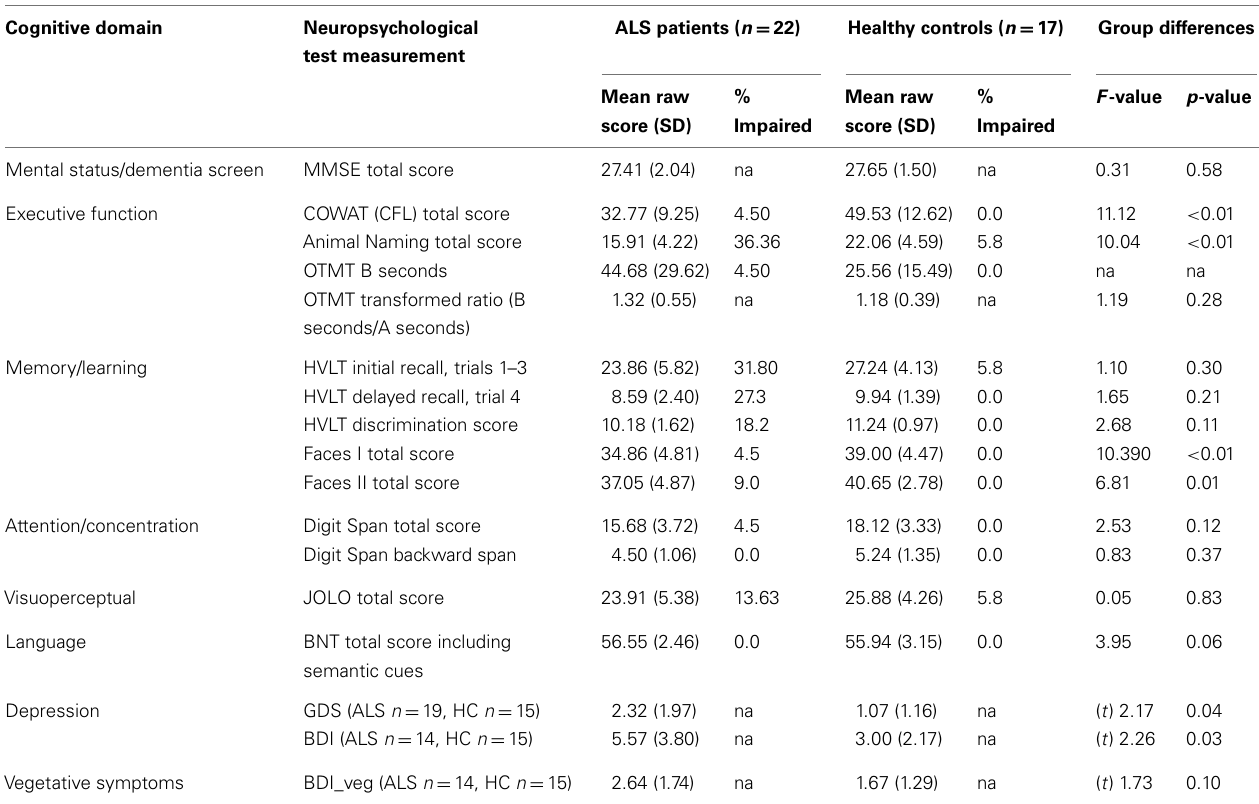
Table 2 | Neuropsychological test results between patients withALS and healthy controls